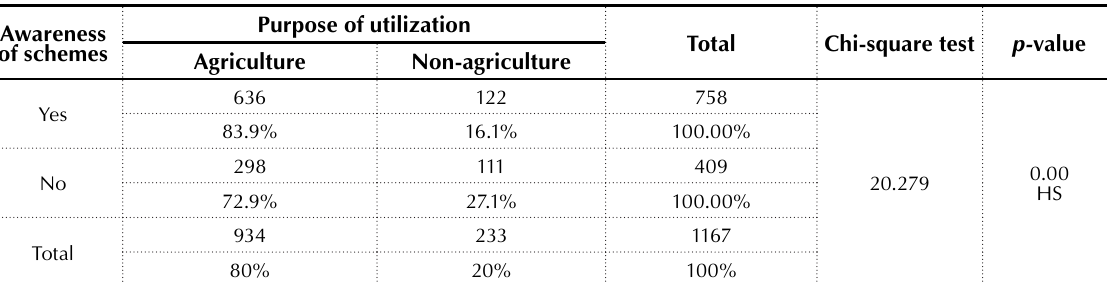
Table 17. Impact of the awareness of schemes on the purpose of agricultural credit utilization